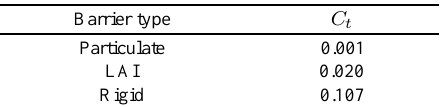
Table 1 C t coefficient values for different barrier types